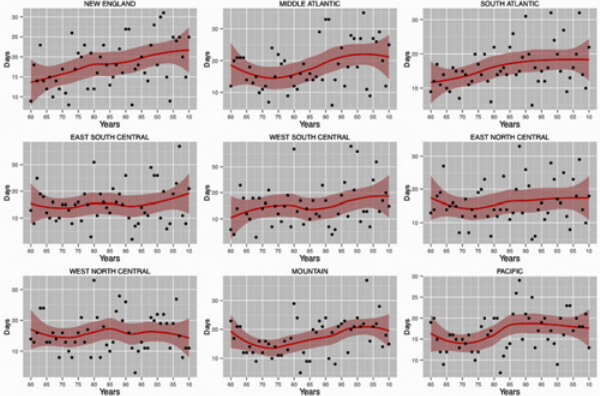
Fig 1. Temporal trend in extreme heat events across census division for the 1960 – 2010